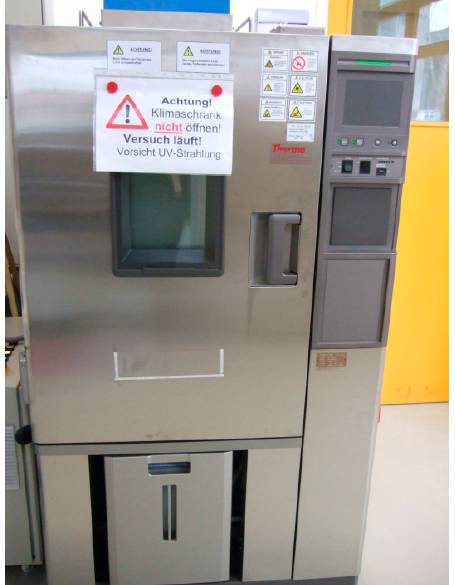
Figure 5. The ThermoTec Laboratory equipment.